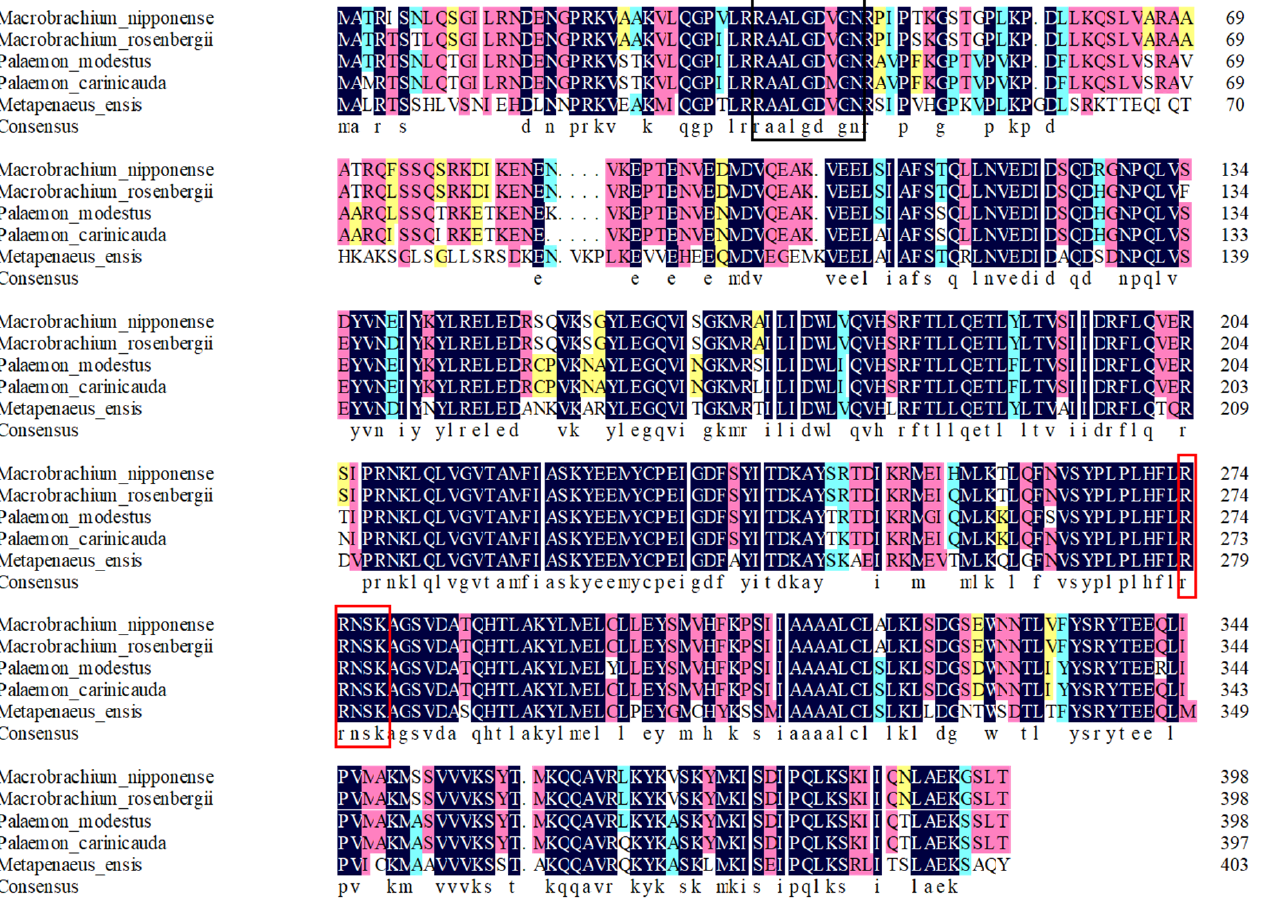
Figure 3. Similarities in amino acid sequences of CycB between different species. The black box indicates the cyclin destruction box and the red box indicates the conserved pkA site.